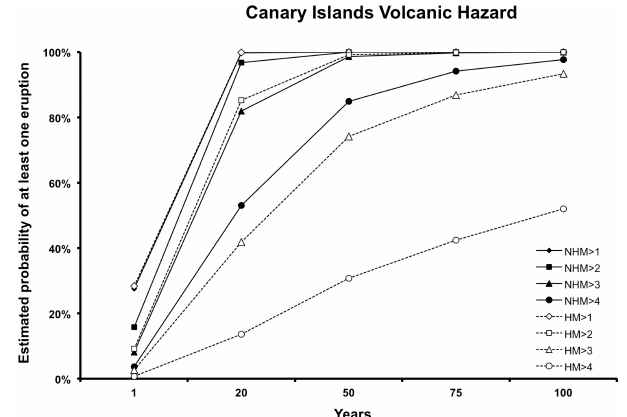
Fig. 6. Probabilities calculated with NHGPPP (solid lines) and Ho- mogeneous Poisson distribution (dashed lines) of at least one erup- tion, with a magnitude greater than a given M threshold for the Canary Islands eruptive